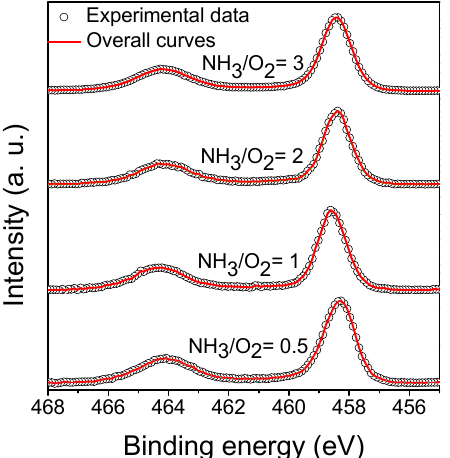
Figure 6. Ti 2 p XPS spectra of the films fabricated under various gas ratios.